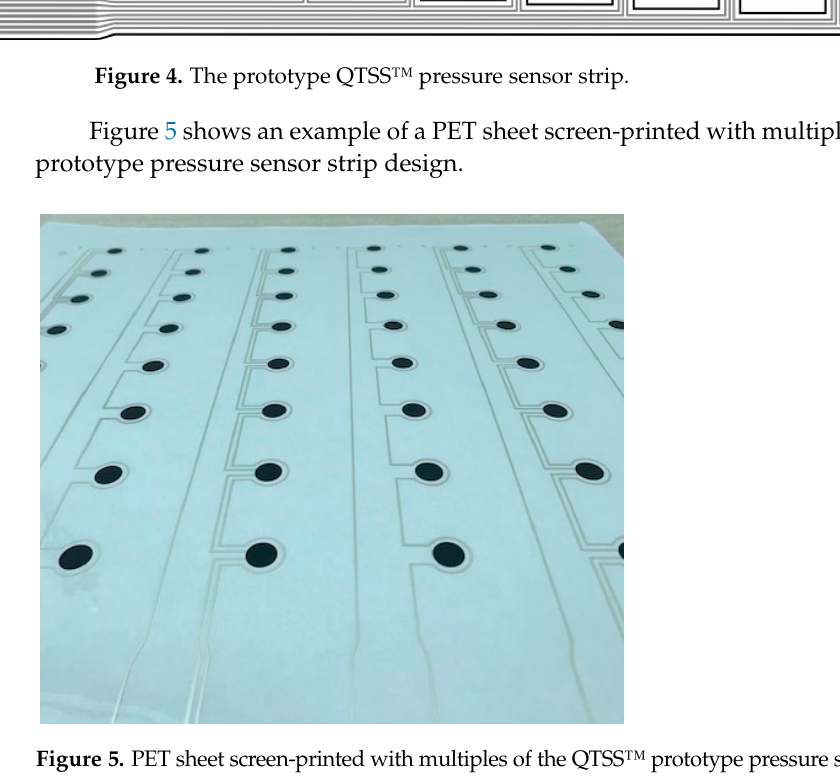
Figure 5. PET sheet screen-printed with multiples of the QTSS™ prototype pressure sensor strip design.